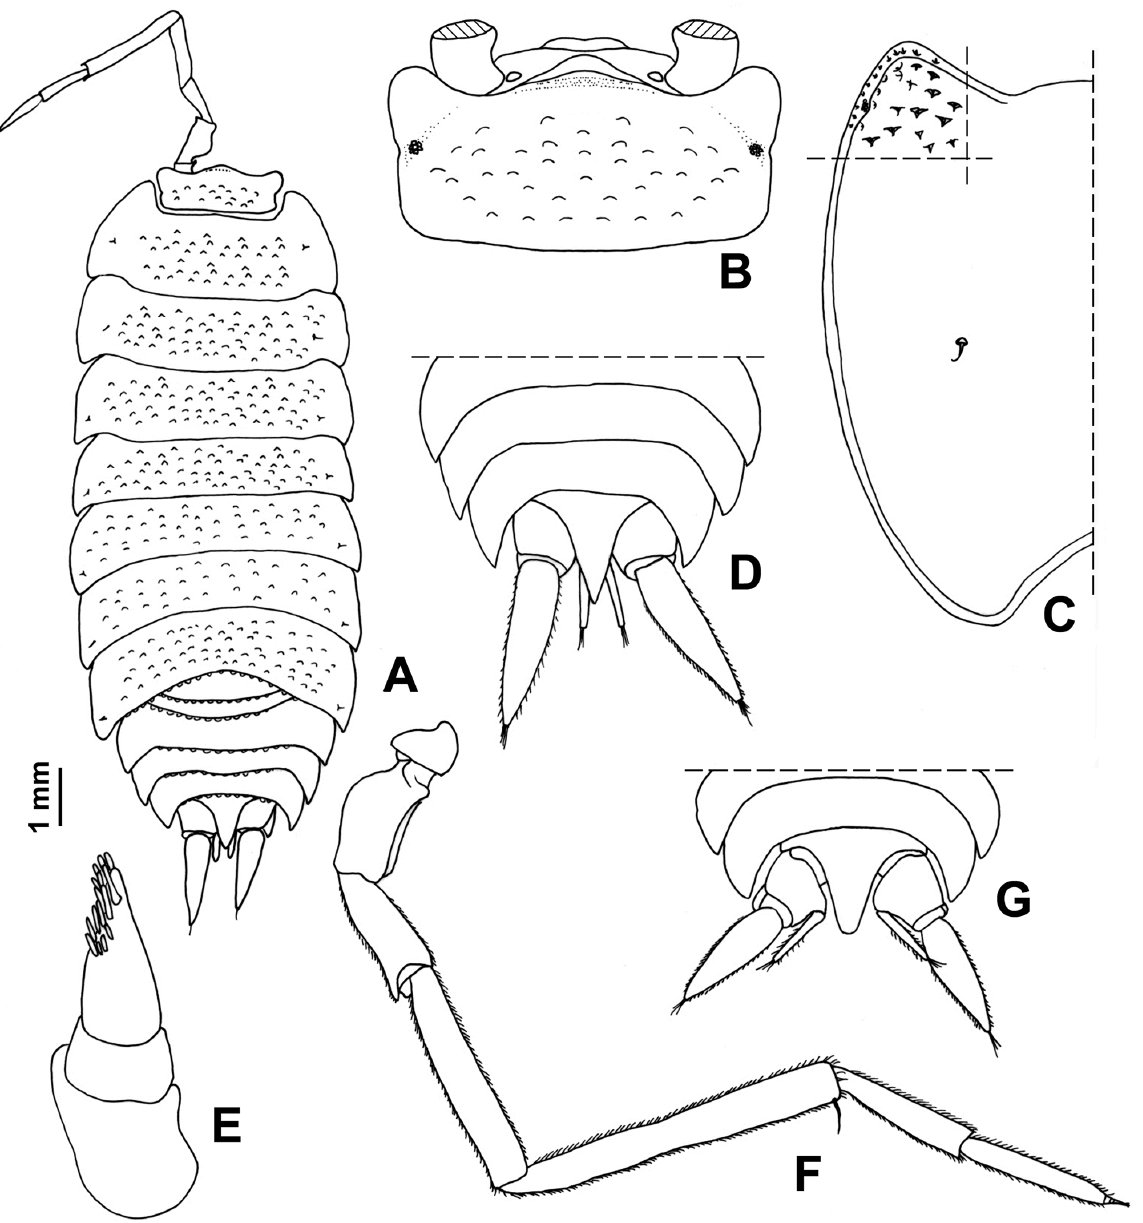
Fig. 28. Porcellio cavernicolus Vandel, 1946. — ♂ from Gruta da Cerâmica, Sicó. A . Adult specimen in dorsal view. B . Cephalon in dorsal view. C . Epimeron of pereonite 1. D . Pleonites 3–5, telson and uropods. E . Antennula. F . Antenna. — ♂ from Gruta d’el Rey. G . Pleonite 4, 5, telson and